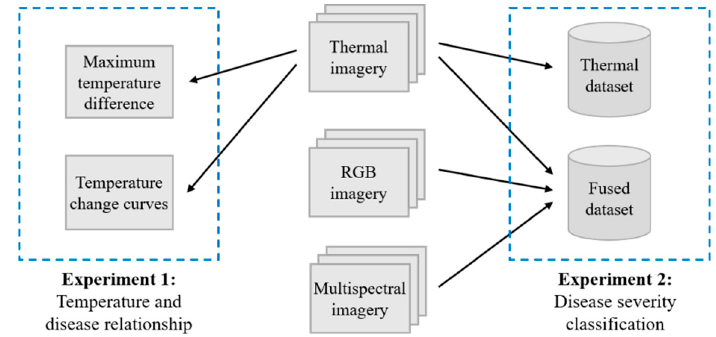
Figure 3. Schematic view of the two experiments. Experiment 1 was concerned with temperature and disease relationship, while experiment 2 was concerned with disease severity classification.